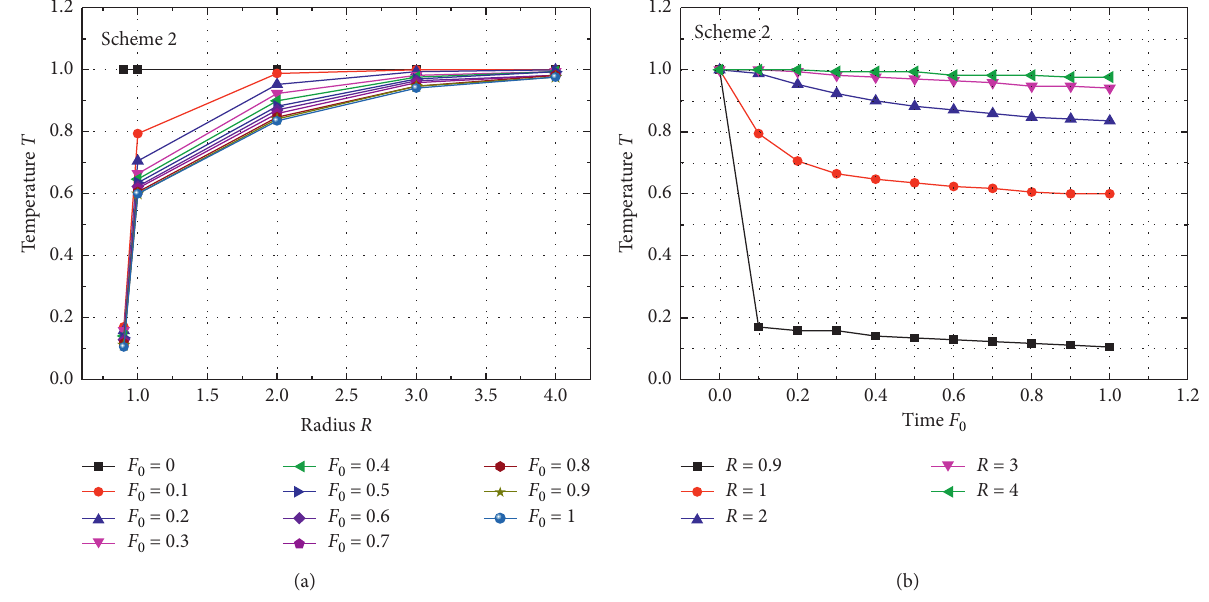
Figure 7: T − R curve and T − F